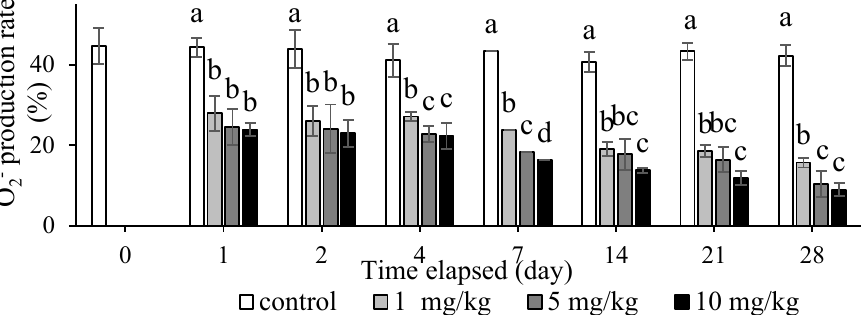
Figure 4. Phagocytic rate ( A ) and phagocytic index ( B ) of hybrid grouper fed with various concen- trations of methylmercury for 28 days. One-way ANOVA and Tukey’ test were performed to com- pare the differences between groups at indicated time point. Values are presented as mean ± SD ( n = 3). Significant differences ( p < 0.05) between treatment groups are indicated by different letters above the bars.